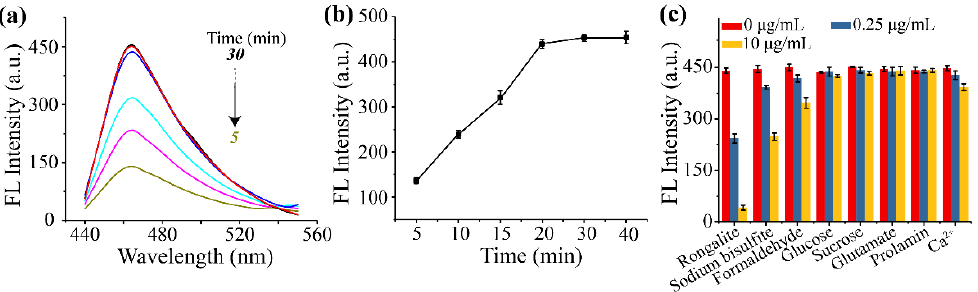
Figure 3. The ( a ) fluorescence spectra, ( b ) fluorescence intensity of the fluorescence sensor with the time ranged from 5 to 40 min. ( c ) The selectivity of the fluorescence sensor.